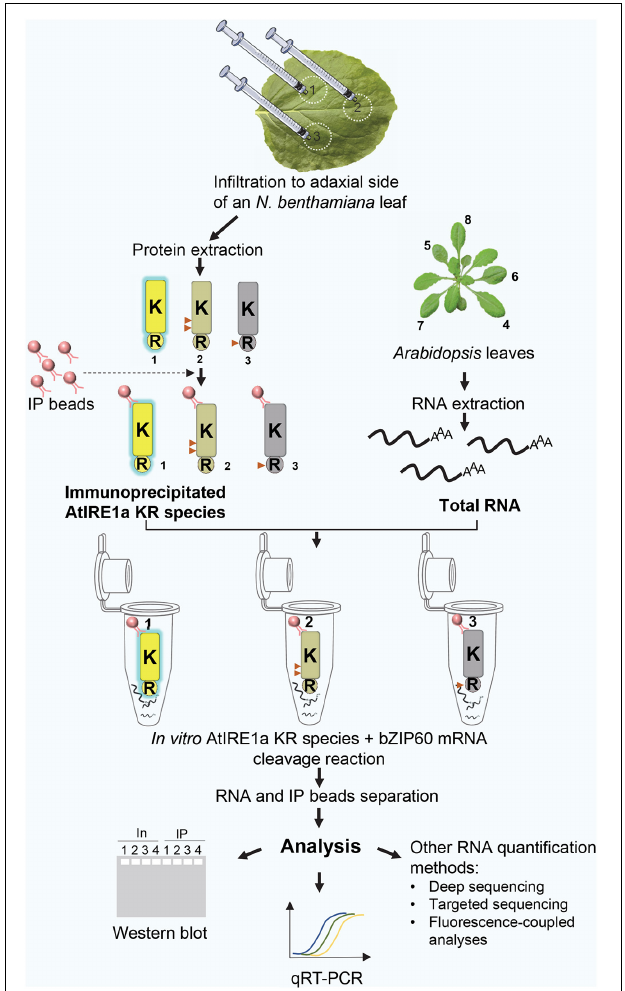
FIGURE 1 | A schematic diagram representing an overview of the quantitative Arabidopsis IRE1a ribonuclease-dependent in vitro mRNA cleavage assay. Numbers 1, 2, 3 represent AtIRE1a-KR, AtIRE1a-KR phospho-dead, and AtIRE1a-KR RNase-dead variants, respectively. The active state of the protein is represented by yellow color and blue glow, the partially reduced activity is depicted in the gray-yellow shade, whereas the inactive state is represented using gray color and no glow. Red triangles on the proteins indicate the approximate positions of point mutations made to generate AtIRE1a-KR variants. Numbers 4, 5, 6, 7, 8 labeling Arabidopsis leaves represent the optimal leaf numbers to be harvested for RNA